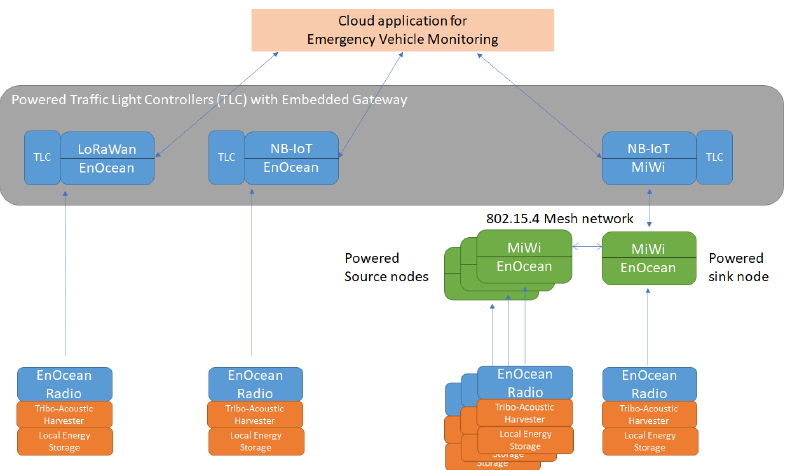
Figure 11. Sensor network